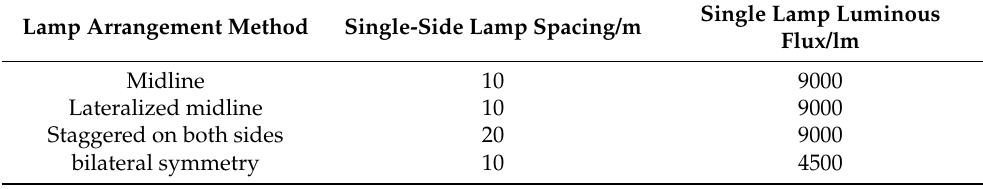
Table 1. Layout of Lamps and Lanterns.